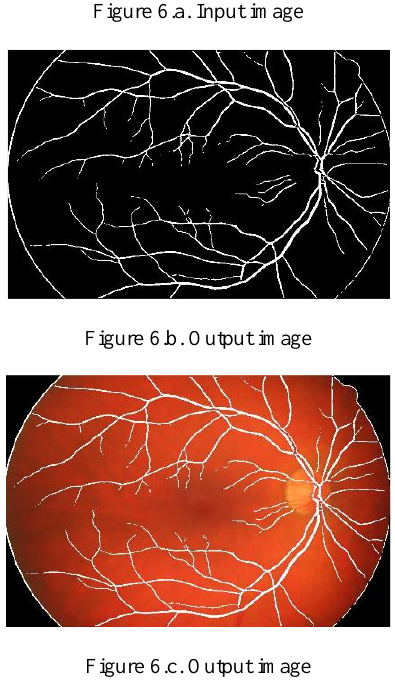
Figure 7.c. Output